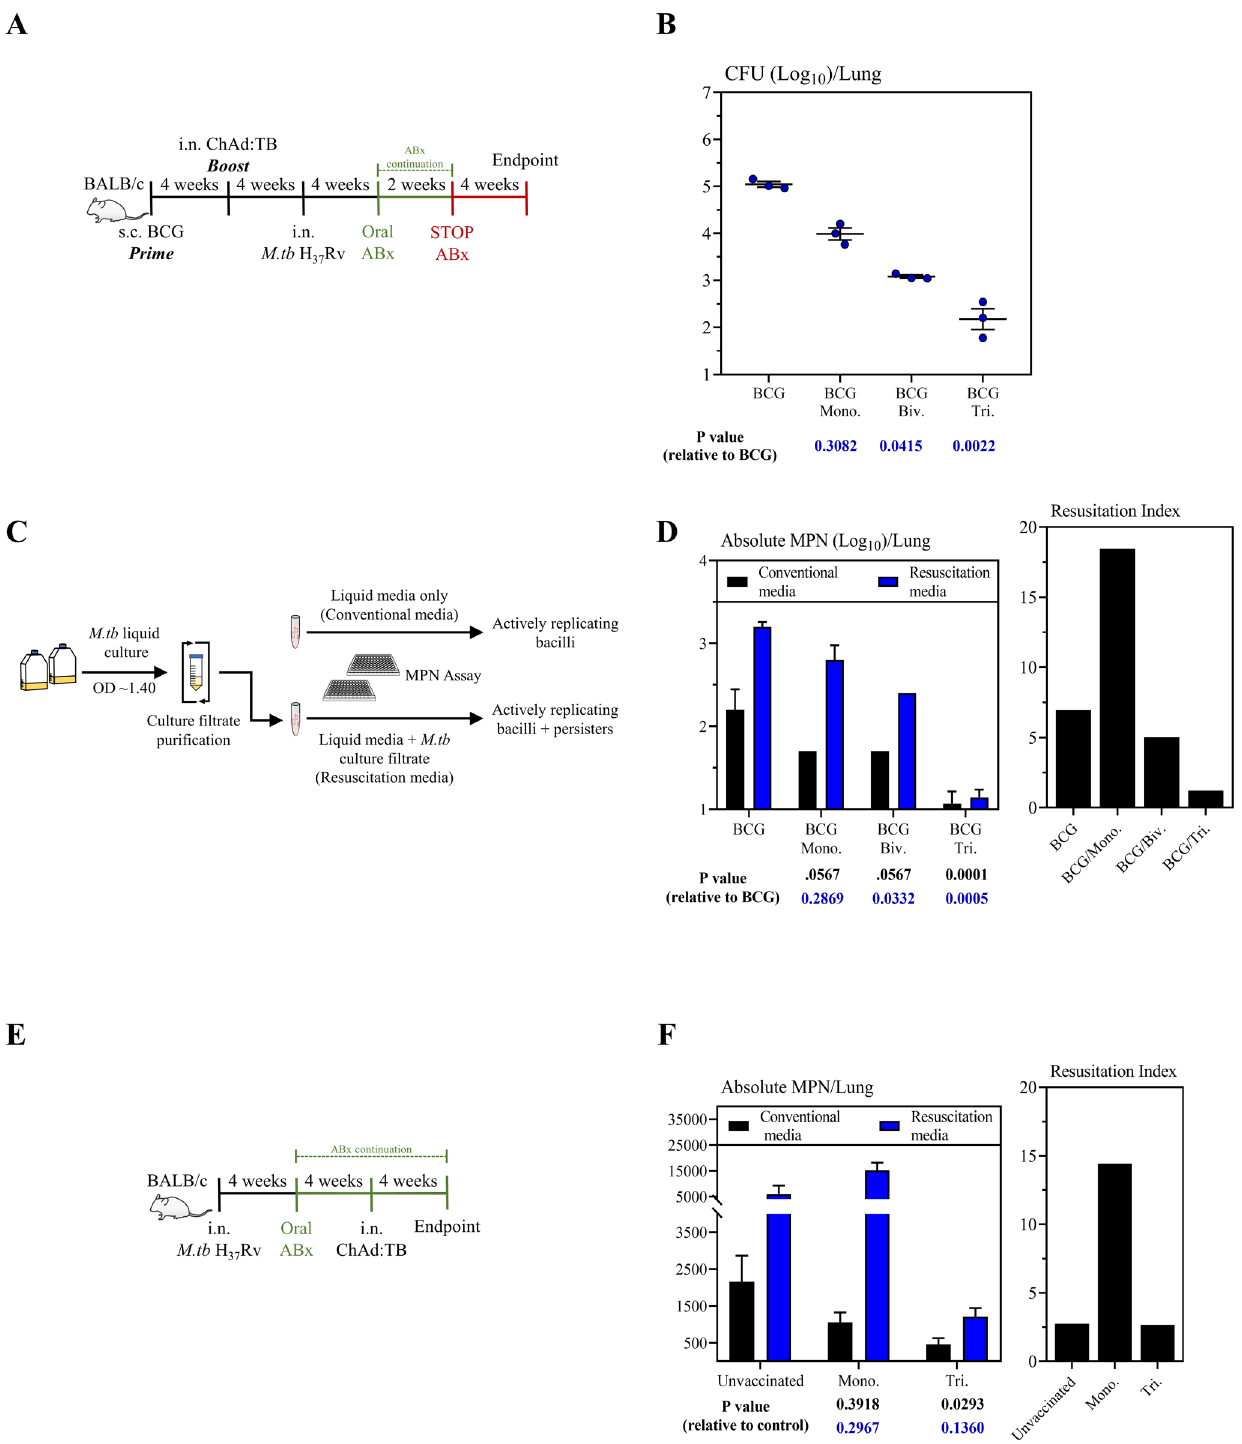
Fig. 4 Protective ef fi cacy of a multivalent ChAd:TB vaccine against M.tb (H 37 Rv) persisters in the BALB/c model. A Experimental schema, pertaining to panel B . B Lung mycobacterial burden (Log 10 colony-forming unit (CFU)) 4 weeks post-ABx cessation. C Diagram depicting generation of M .tb culture fi ltrates for assessment of mycobacterial persisters in lung homogenates. D Left: Most probable number (MPN) estimates (Log 10 ) to assess actively replicating bacilli (conventional media, black bars) and persisters (resuscitation media, blue bars). Right: Resuscitation Index, as calculated by a ratio of persisters-to-actively replicating bacilli. E Experimental schema, pertaining to panel F . F Left: Most Probable Number (MPN) estimates to assess actively replicating bacilli (conventional media, black bars) and persisters (resuscitation media, blue bars). Right: Resuscitation Index, as calculated by a ratio of persisters-to-actively replicating bacilli. Data presented in ( B , D , F ) represent mean ± SEM of n = 3 mice/group. Data are representative of one independent experiment. Statistical analysis for ( B , D , F ) was performed using a nonparametric Kruskal – Wallis with Dunn ’ s multiple comparison